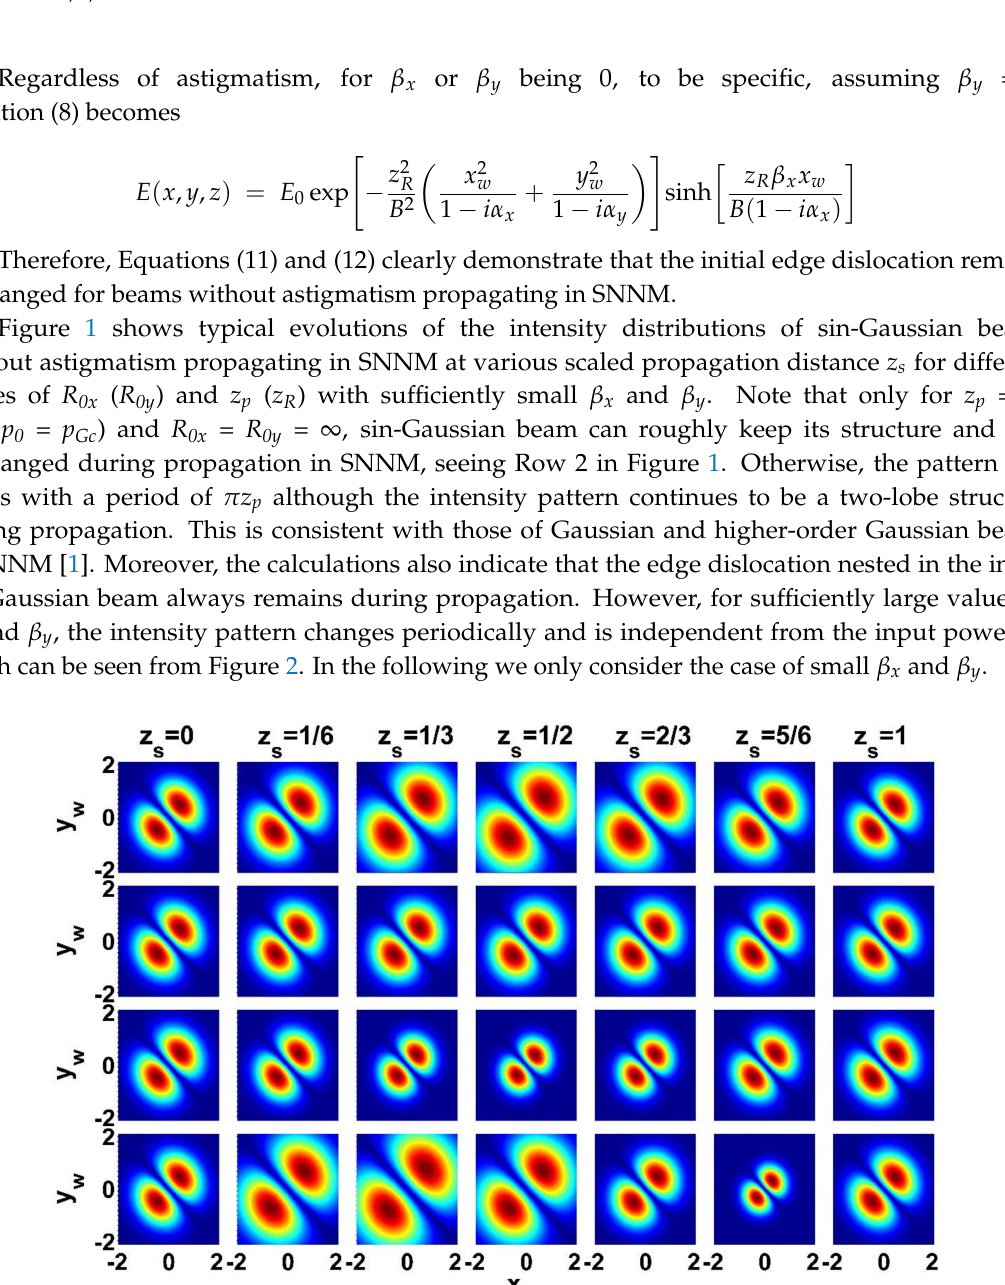
Figure 1. Evolution of intensity distributions of sin-Gaussian beams with the scaled propagation distance z s for β x = 0.6, β y = 0.6. The other parameters are for Row 1: R 0x = R 0y = ∞ and z p = Row 2: R 0x = R 0y = ∞ and z p = z R ; Row 3: R 0x = R 0y = ∞ and z p = z R / and z p = z R , respectively.